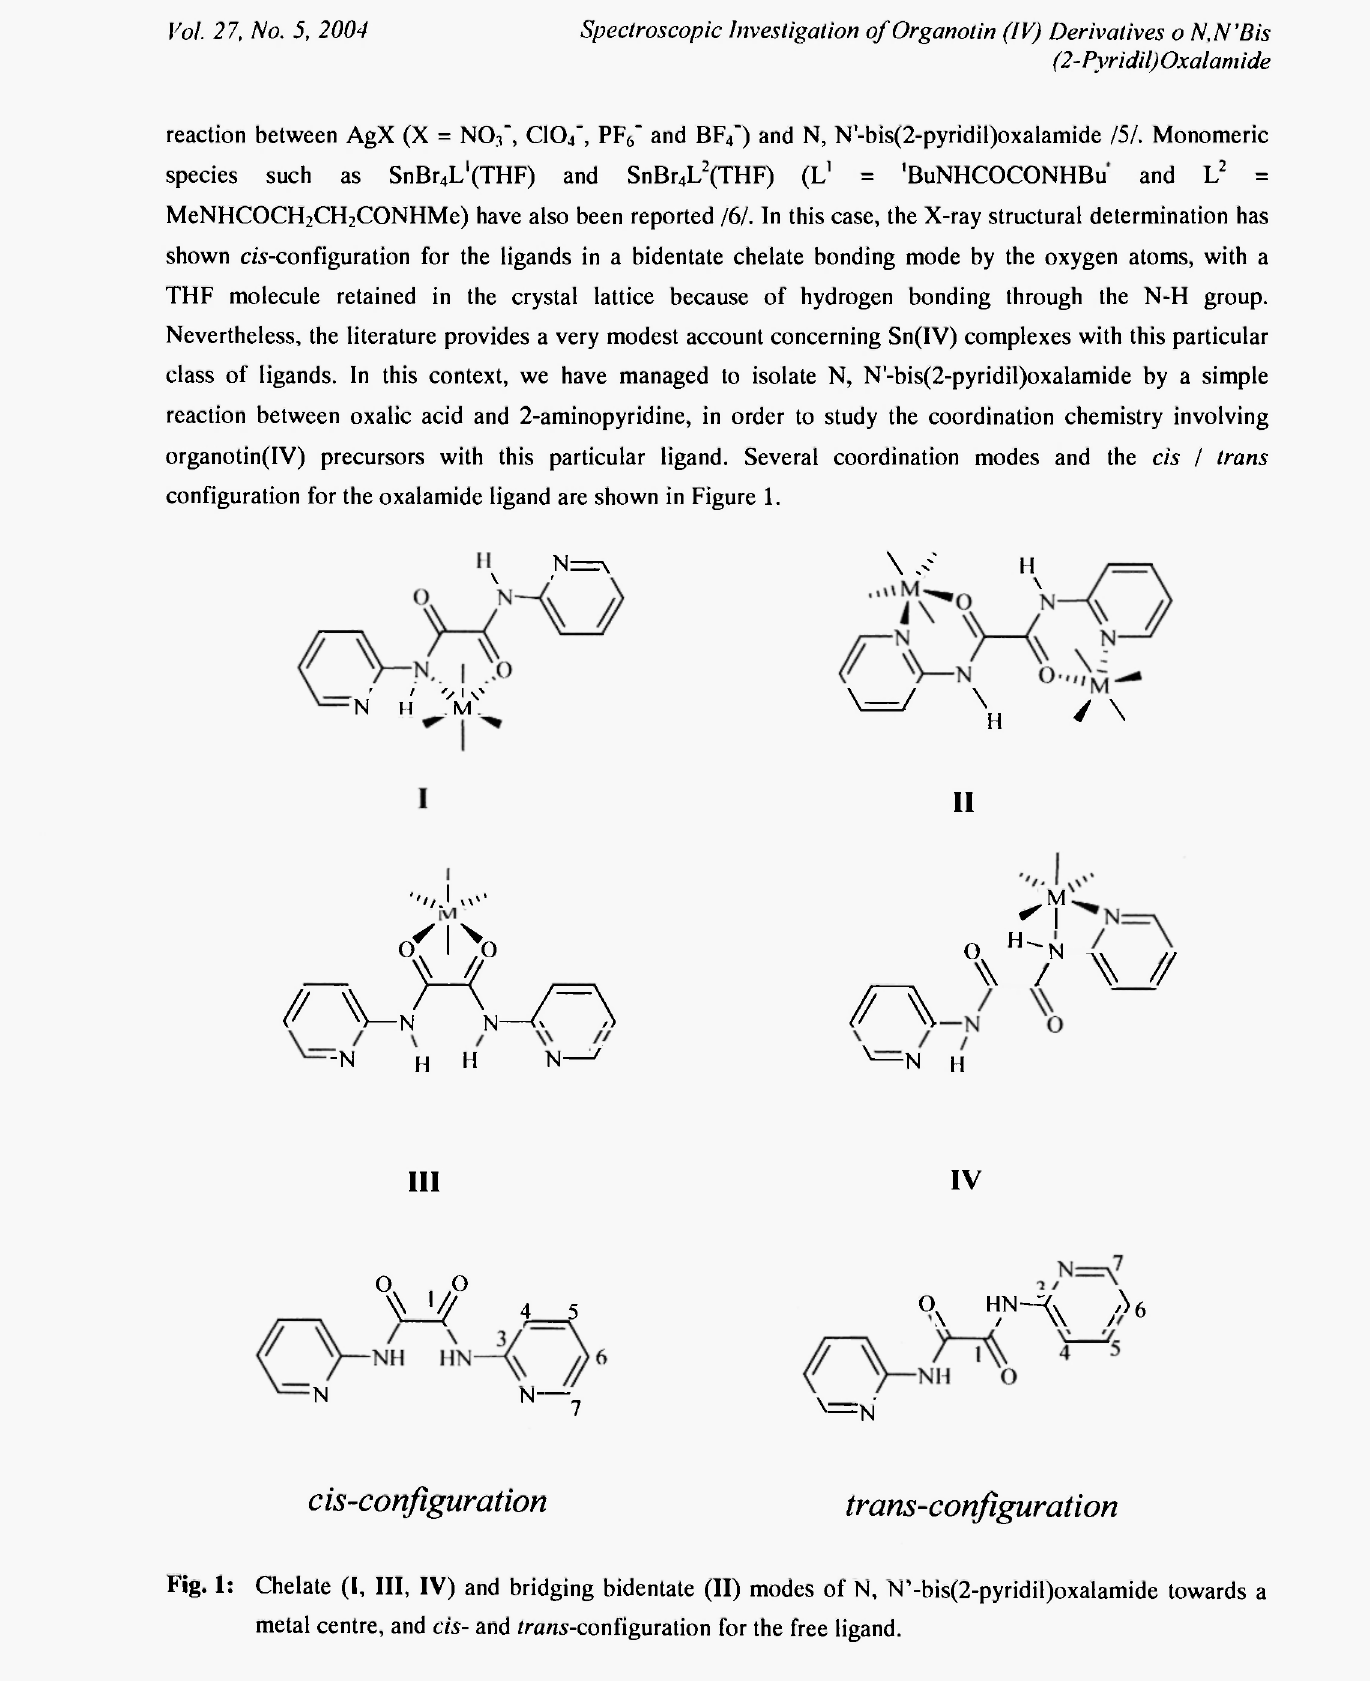
Fig. 1: Chelate (I, III, IV) and bridging bidentate (II) modes of N, N'-bis(2-pyridil)oxalamide towards a metal centre, and cis- and ira/is-configuration for the free